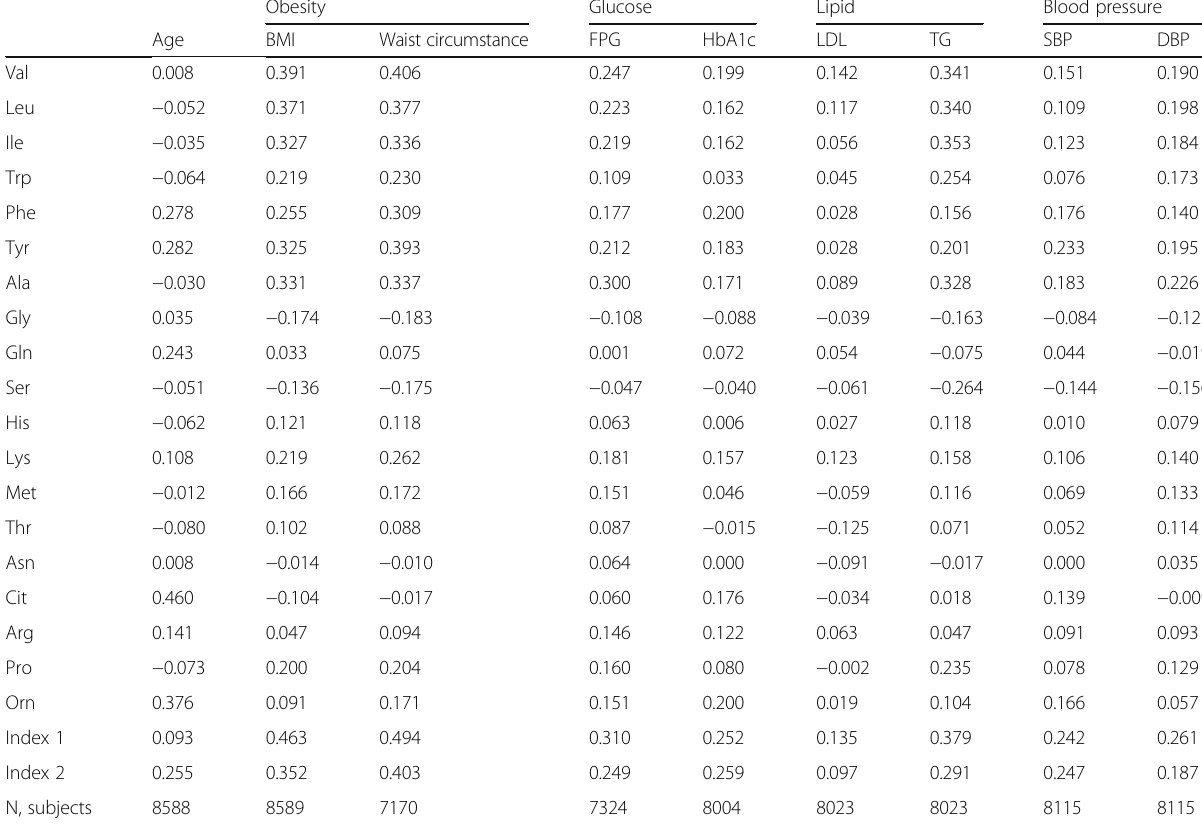
Table 3 Correlation between PFAA profiles and metabolic variables Obesity Glucose Lipid Blood